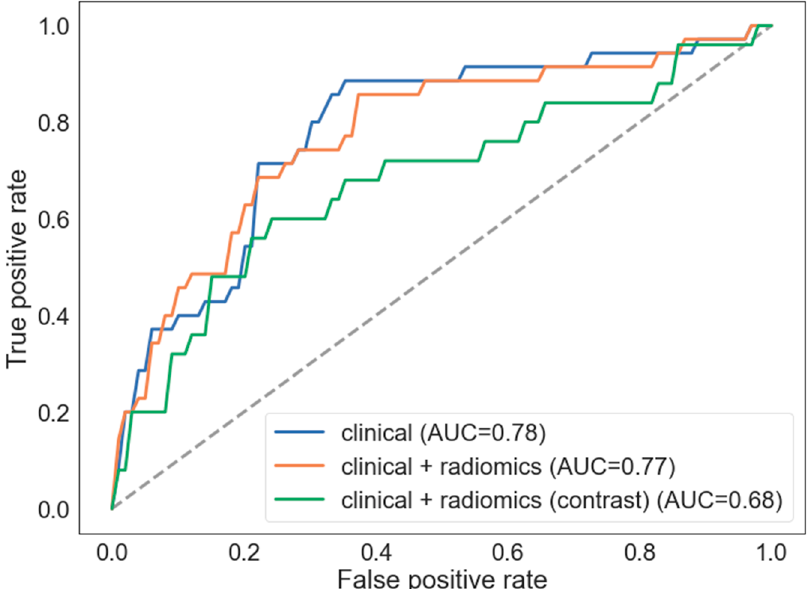
Figure 3. Performance of the clinical only and combined clinical-radiomics model based on non- contrast enhanced images. The AUROC values are averaged over 5 cross-validation folds. Adding radiomics to clinical features did not improve performance (AUROC 0.78 vs. 0.77 respectively).